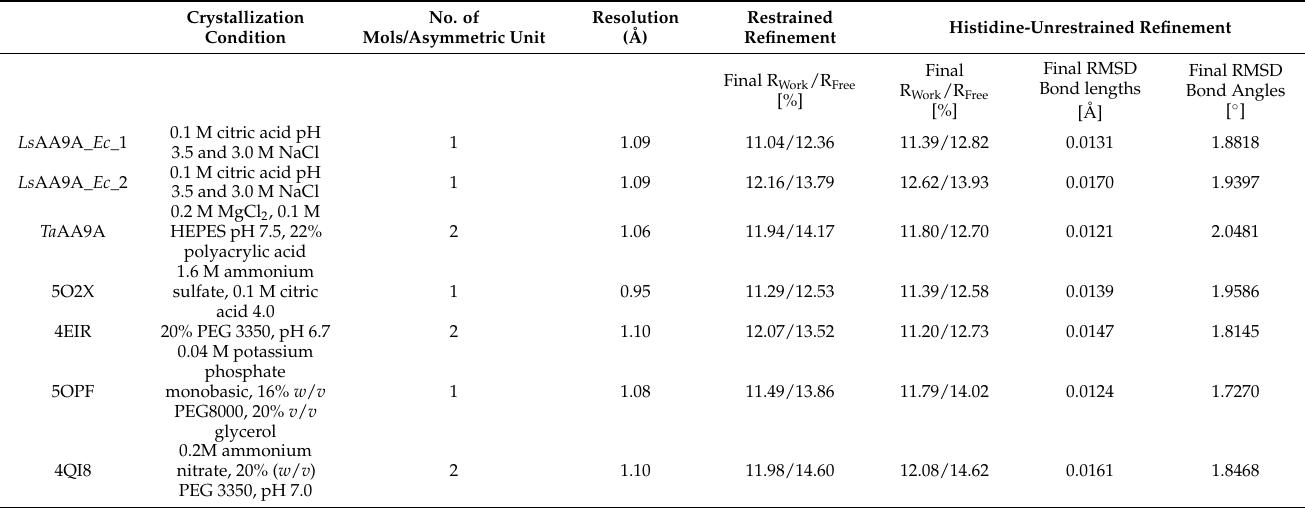
Table 2. Refinement statistics after restrained and His-unrestrained refinement of the seven structures in this study.